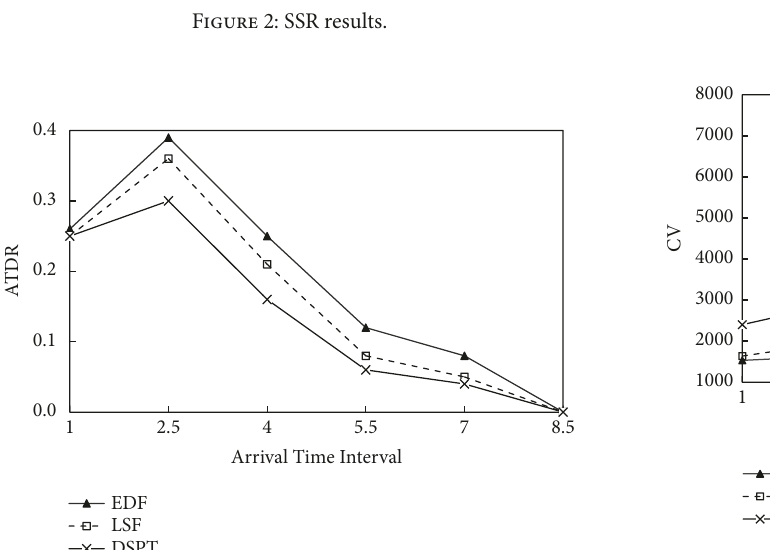
Figure 2: SSR results.